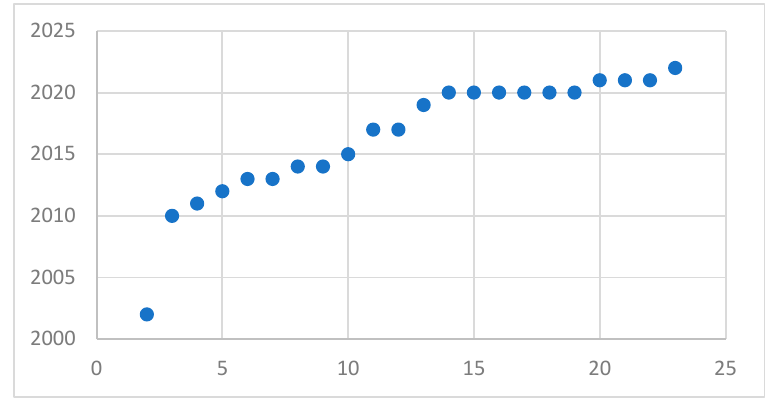
Figure 6. Development trend of multi-signal articles.